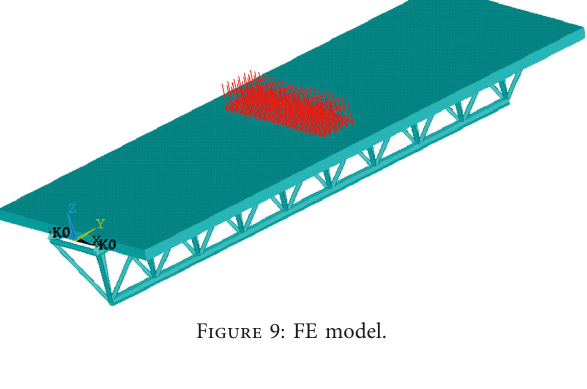
Figure 9: FE model.